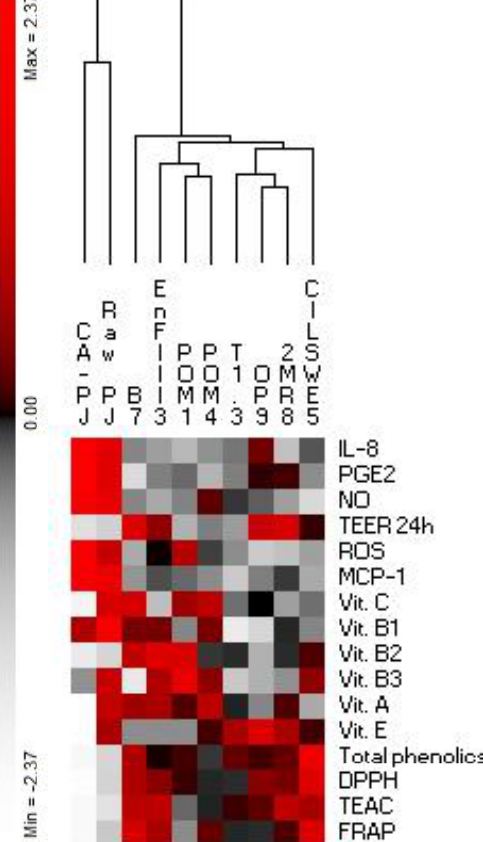
Figure 6. Permutation analysis of functional activities of raw Portulaca oleracea L. juice (Raw-PJ), chemically acidified PJ (CA-PJ), and PJs fermented (30 °C for 36 h) by Lactobacillus plantarum POM1, T1.3, and EnFIII3, Lactobacillus brevis POM4, Lactobacillus rossiae 2MR8, Pediococcus pentosaceus CILSWE5, Leuconostoc mesenteroides OP9, and Lactobacillus kunkeei B7. Normalized data for antioxidant activities (DPPH, TEAC, and FRAP) and levels of bioactive compounds (vitamins and total phenolics) in PJs, and pro-inflammatory mediators (PGE2, NO, IL-8, and MCP-1), reactive oxygen species (ROS), and transepithelial electrical resistance (TEER) levels in Caco-2 cells treated with PJs were subjected to permutation analysis.